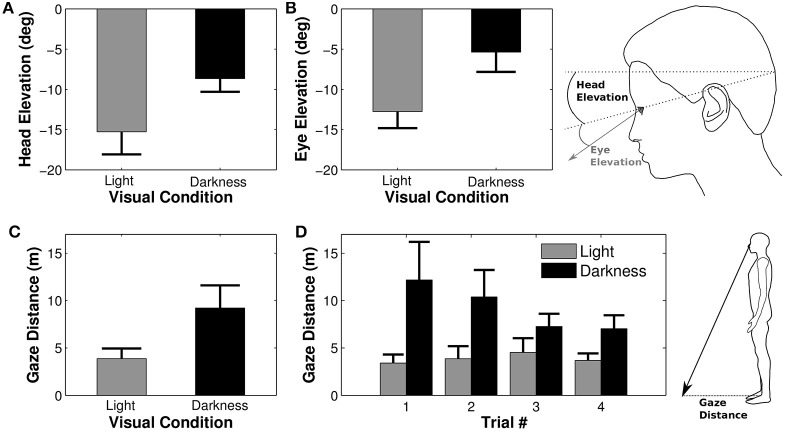
Elevation of the eye and the head. Average elevations of the head (A) and of the eye in the head (B) depending on the visual condition. Negative values indicate a downward orientation (below horizon for the head and below primary eye position for the eye). Large head and eye elevations lead to a shorter distance between gaze/floor intersection and the projection onto the ground of the right orbit [i.e., gaze distance, (C), (D)].